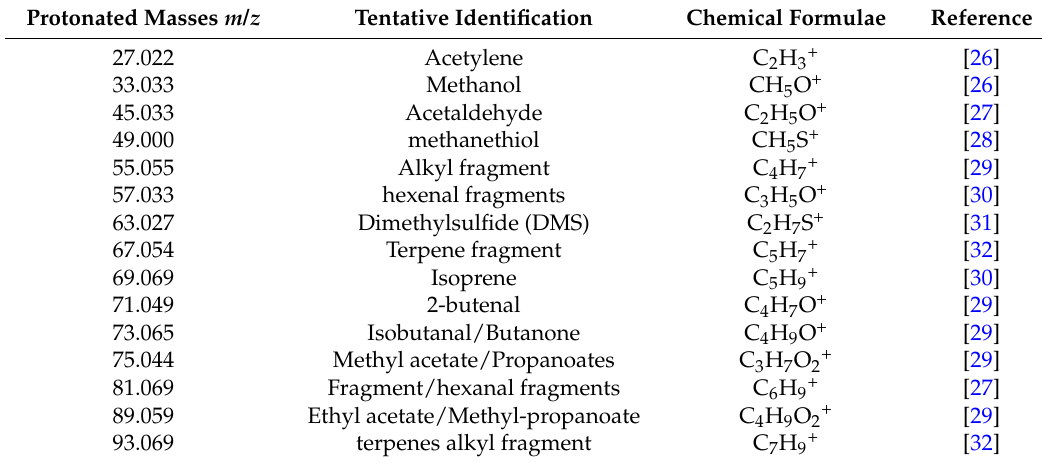
Table 4. Protonated masses, tentative identification, molecular formula, and references of the investigated volatile